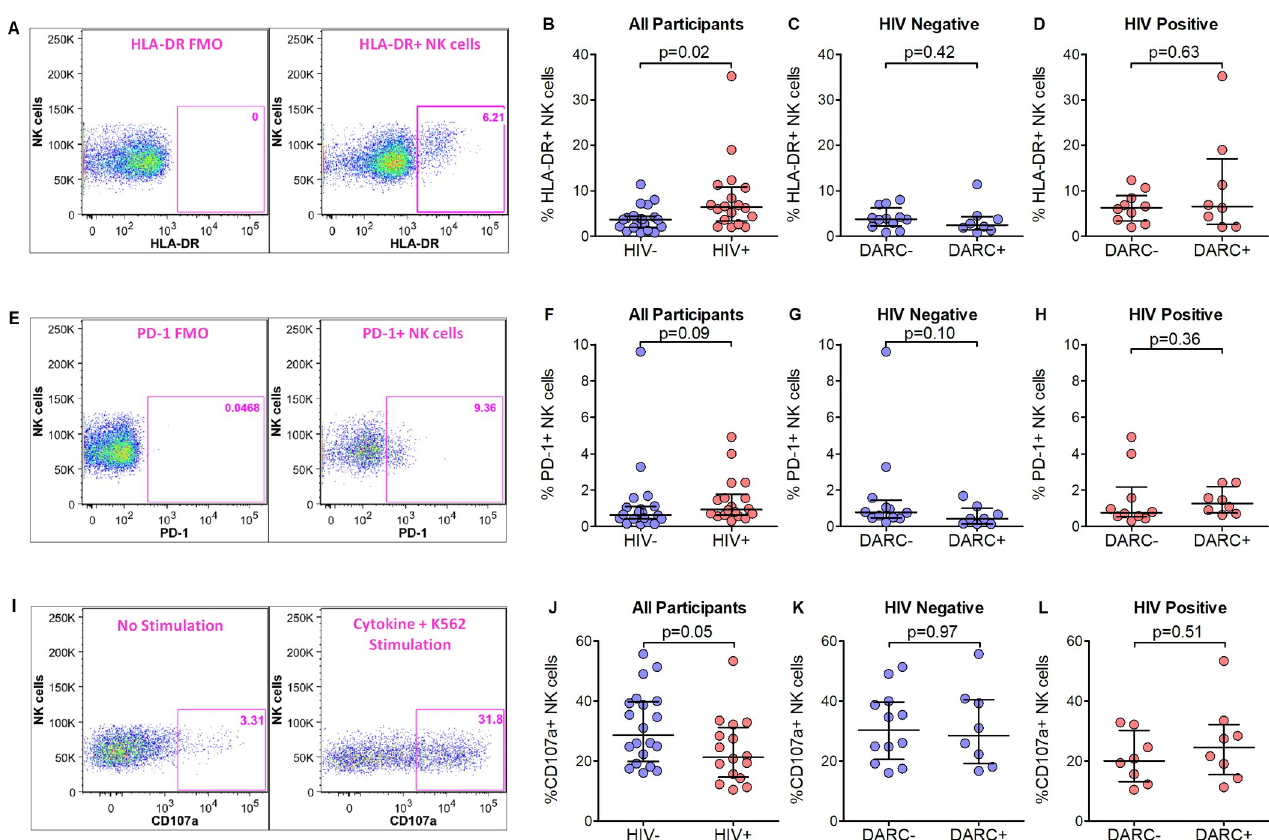
Fig 3. NK cell activation, exhaustion and degranulation. (A) Gating strategy of activation marker HLA-DR on total NK cells. (B) Expression of activation marker HLA-DR on total NK cells in all participants. Expression of activation marker HLA-DR grouped by DARC genotype on total NK cells in HIV negative (C) and HIV positive (D) individuals. (E) Gating strategy of exhaustion marker PD-1 on total NK cells. (F) Expression of exhaustion marker PD-1 on total NK cells in all participants. Expression of PD-1 marker grouped by DARC genotype on total NK cells in HIV negative (G) and HIV positive (H) individuals. (I) Gating strategy of degranulation marker CD107a on total NK cells. (J) Expression of degranulation marker CD107a on total NK cells in all participants. CD107a expression on total NK cells stratified by DARC genotype in HIV negative (K) and HIV positive (L) individuals. Dots indicate individual data points. Medians are indicated and extended to interquartile range with whiskers. Abbreviations: DARC, Duffy antigen receptor for chemokines.